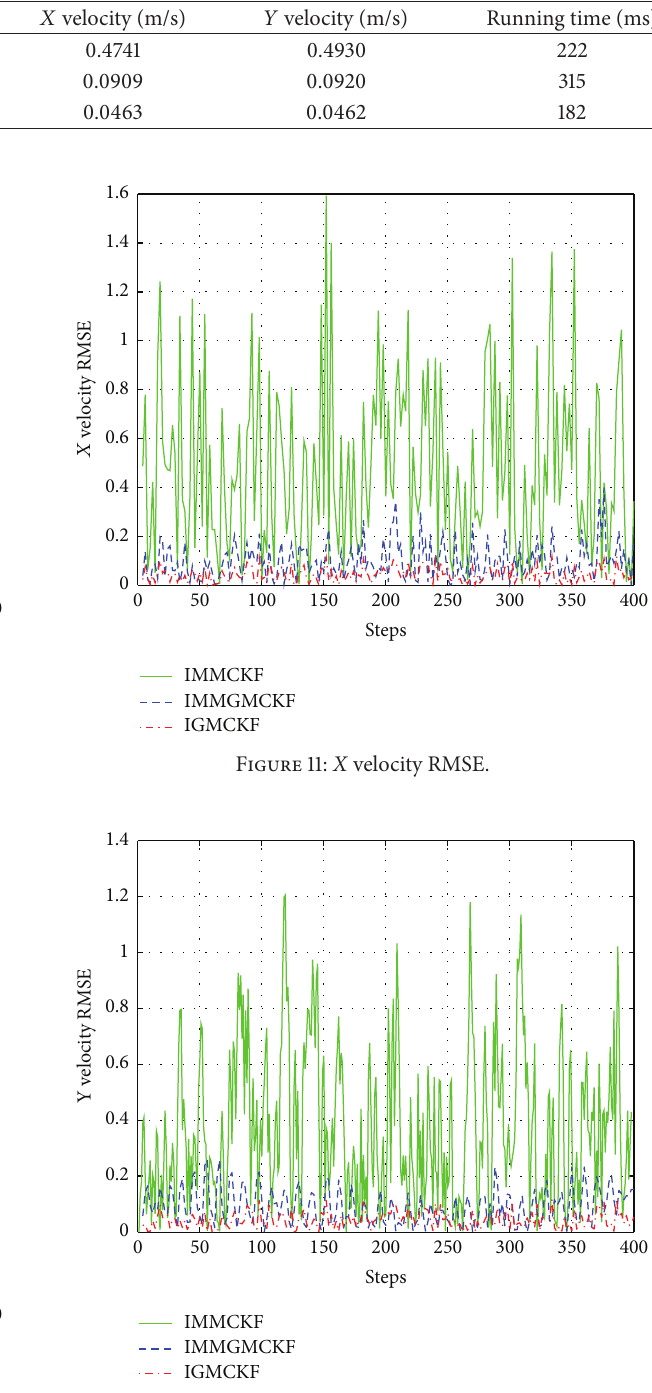
Figure 12: Y velocity